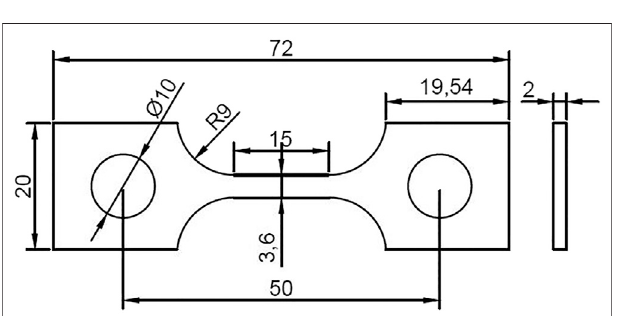
FIGURE 1 | The microstructure of HP-13Cr SS.